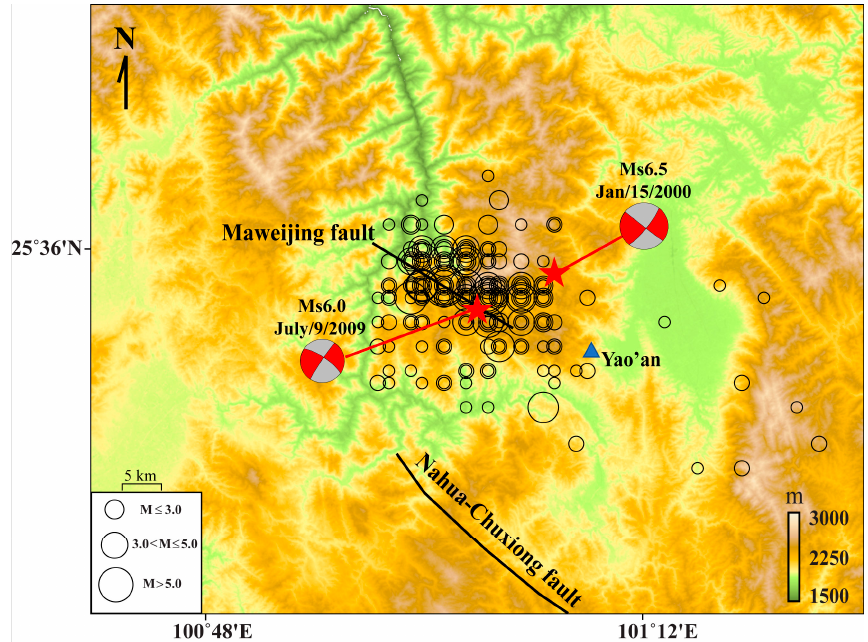
Figure 7. The focal mechanisms of the 2000 Ms6.5 Yao’an earthquake and 2009 Ms6.0 Yao’an earthquake [47,49], and the earthquake sequence of 2009 Ms6.0 Yao’an earthquake. The blue solid triangle represents the major city.